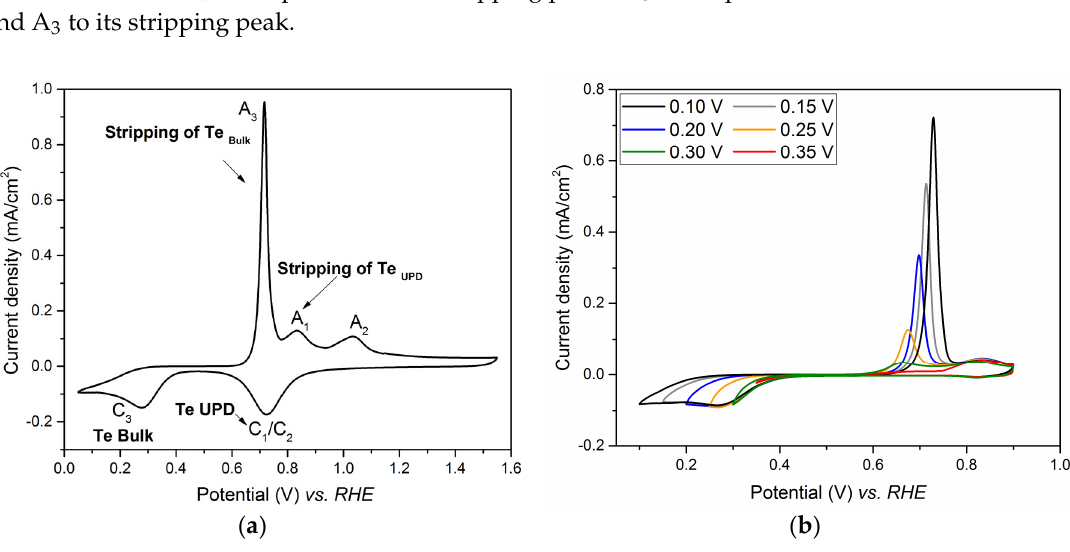
Figure 3. Steady-state voltammetric response of the Pt electrode in 0.1 M HClO 4 (dotted line) and first cycle profile after Pt electrode polarization in 1 mM TeO 2 for 450 s at 0.35 V vs. RHE (full line), sweep rate = 40 mV/s. 3.3. Te Replacement by Pt Following the Te underpotential deposition on bare gold, the Te film was galvanically exchanged with platinum via SLRR. The atomic layer of Te was then oxidized while PtCl 62− ions were reduced, replacing the Te layer by a Pt layer. The time needed to obtain the highest replacement rate was been determined from the I-t curve (Figure 4), and is 450 s.